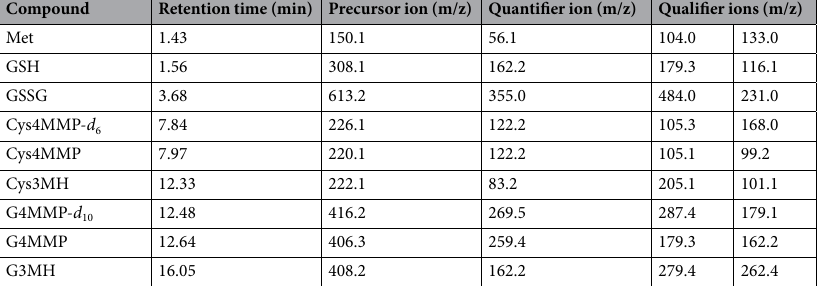
Table 5. Chromatographic retention times and selected reaction monitoring